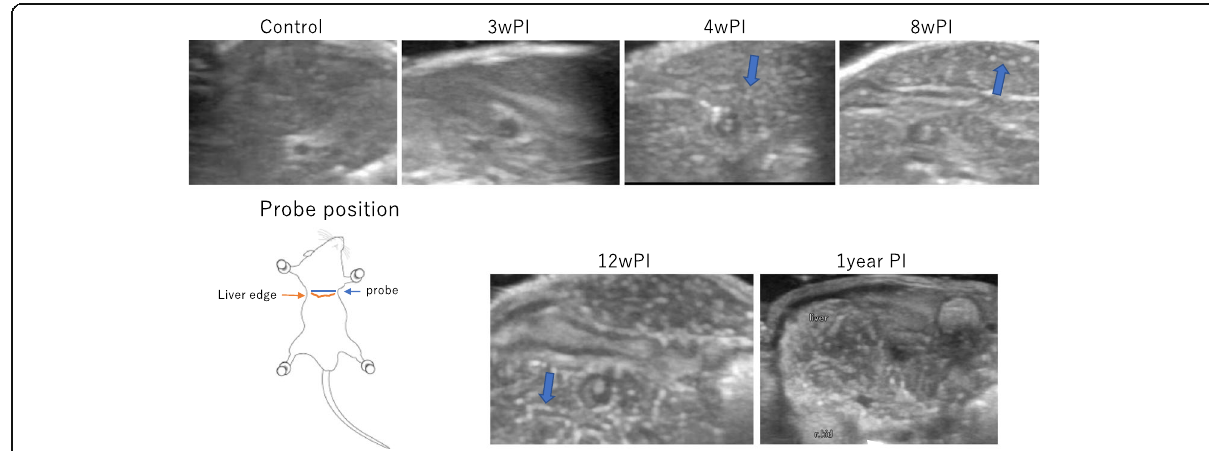
Fig. 3 Change of the liver parenchyma in ultrasonography. At 3 weeks PI, there was no marked change in the liver parenchyma and spots appeared from 4 weeks PI (arrow). After that, the spots were enlarged, and at 8 weeks PI, a thin linear change was also detected (arrow), which became more prominent at 12 weeks PI (arrow). A thick linear change was conspicuous at 1 year